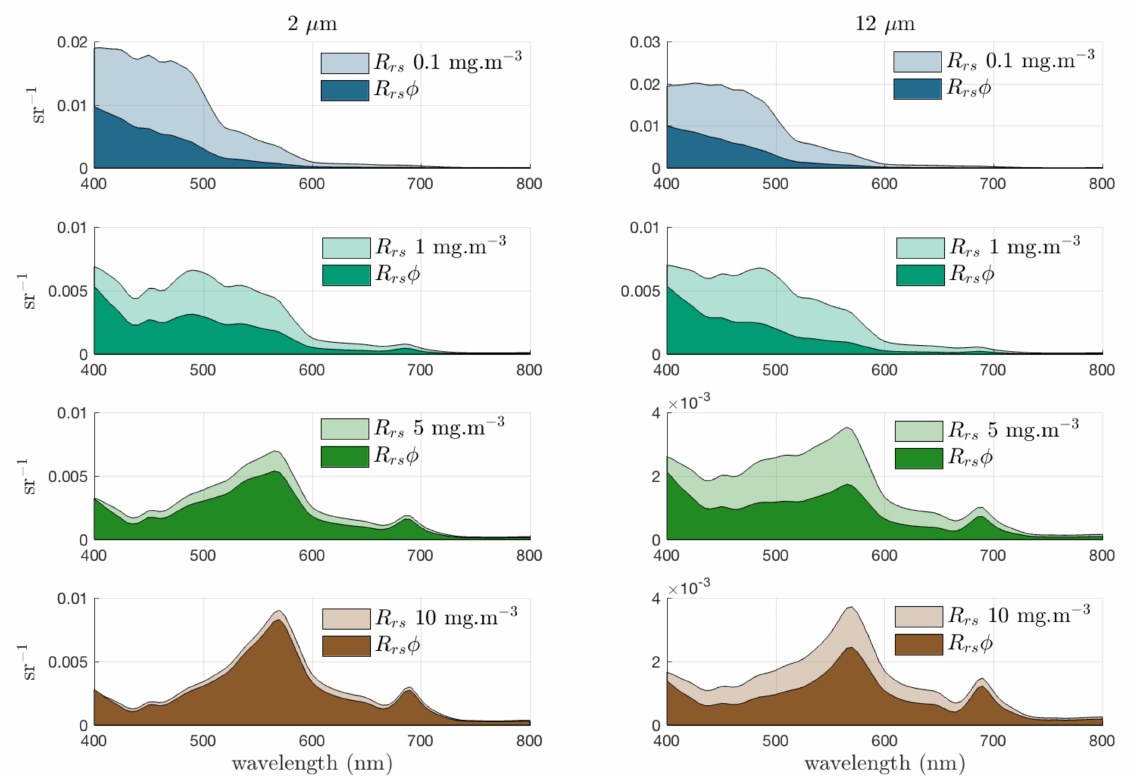
Figure 2. Relative contribution of phytoplankton to total R rs (with a gd ( 400 ) = 0.07 · [ Clh a ] 0.75 and b bnap ( 550 ) = 0.005 m − 1 ) for increasing biomass with effective diameter, D ef f = 2 and 12 µm. The absorption caused by coloured dissolved organic matter ( a gd ) covaries with Chl a , whereas non-algal backscatter b bnap is constant. These populations are idealised examples and not intended to represent any observed relationship between Chl a concentration and D ef f . Reprinted with permission from